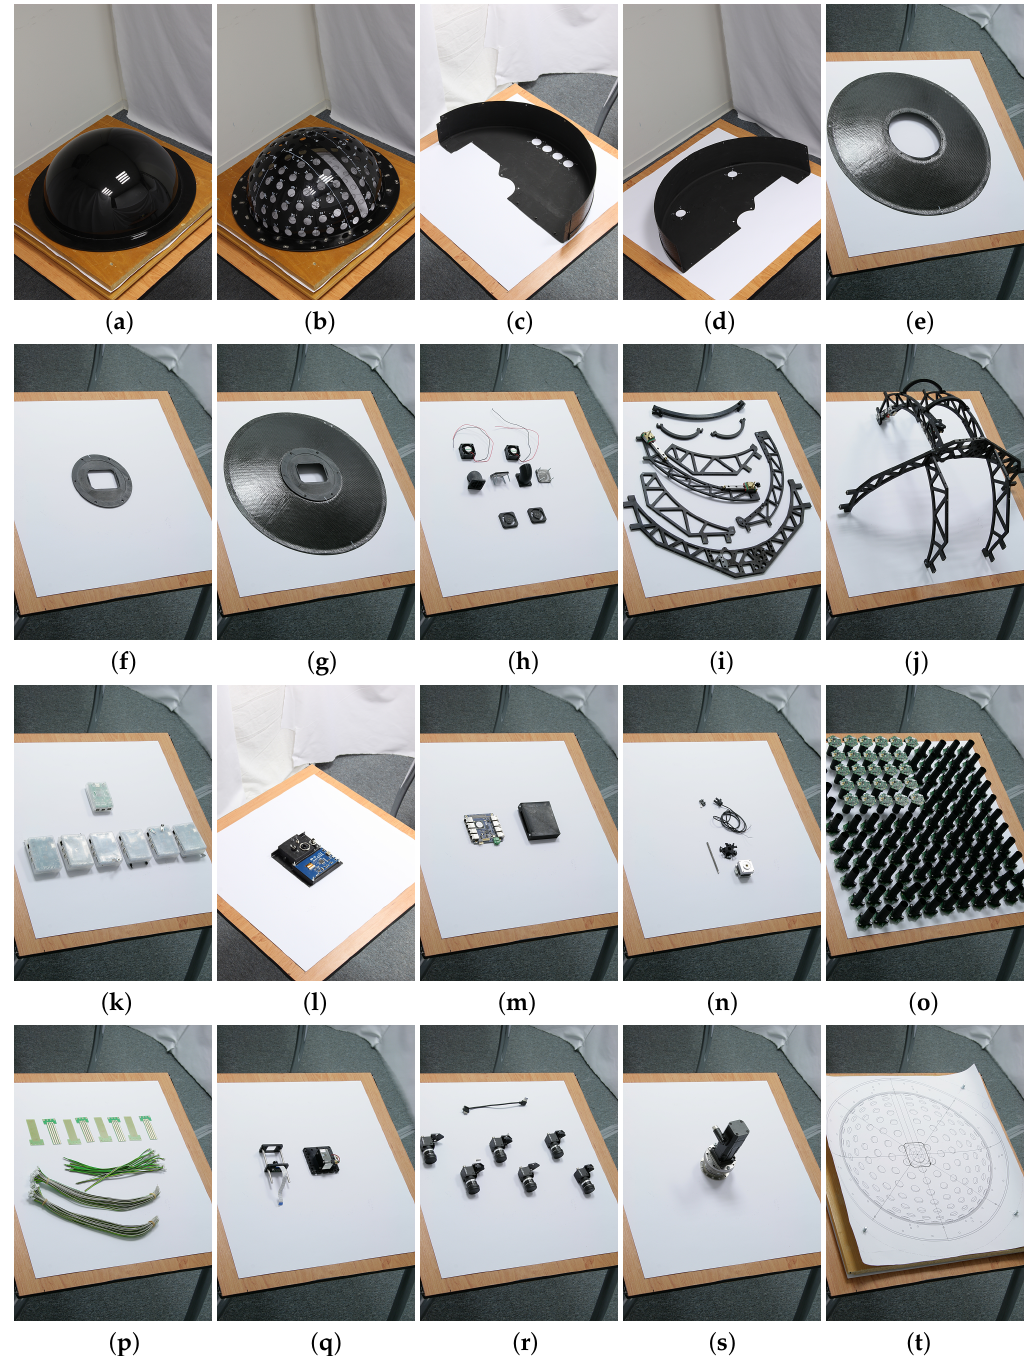
Figure 16. The individual parts of the lightdrum and the plan used for the initial adjustment procedure of the cameras and LED modules. ( a ) PMMA dome semi-product; ( b ) PMMA dome with CNC milled holes; ( c ) first top carbon cover part; ( d ) second top carbon cover part; ( e ) bottom carbon conic cover; ( f ) 3D printed endpiece with measurement aperture; ( g ) bottom carbon conic cover with mounted endpiece; ( h ) lightproof air ventilation parts; ( i ) inner aluminium frame and approximate circular positioning mechanism in pieces; ( j ) assembled inner aluminium frame and approximate circular positioning mechanism; ( k ) six Hardkernel Odroid-XU3 and one Raspberry Pi 2 microcomputers; ( l ) panel with display and connectors; ( m ) embedded gigabit Ethernet switch and its cover; ( n ) stepper motor with trapezoidal screw; ( o ) LED modules; ( p ) eight RS485 distribution boards and cables; ( q ) auto-collimator parts; ( r ) cameras with lenses and USB 3.0 cable; ( s ) geared servo motor; and ( t ) paper plan used for assembly and